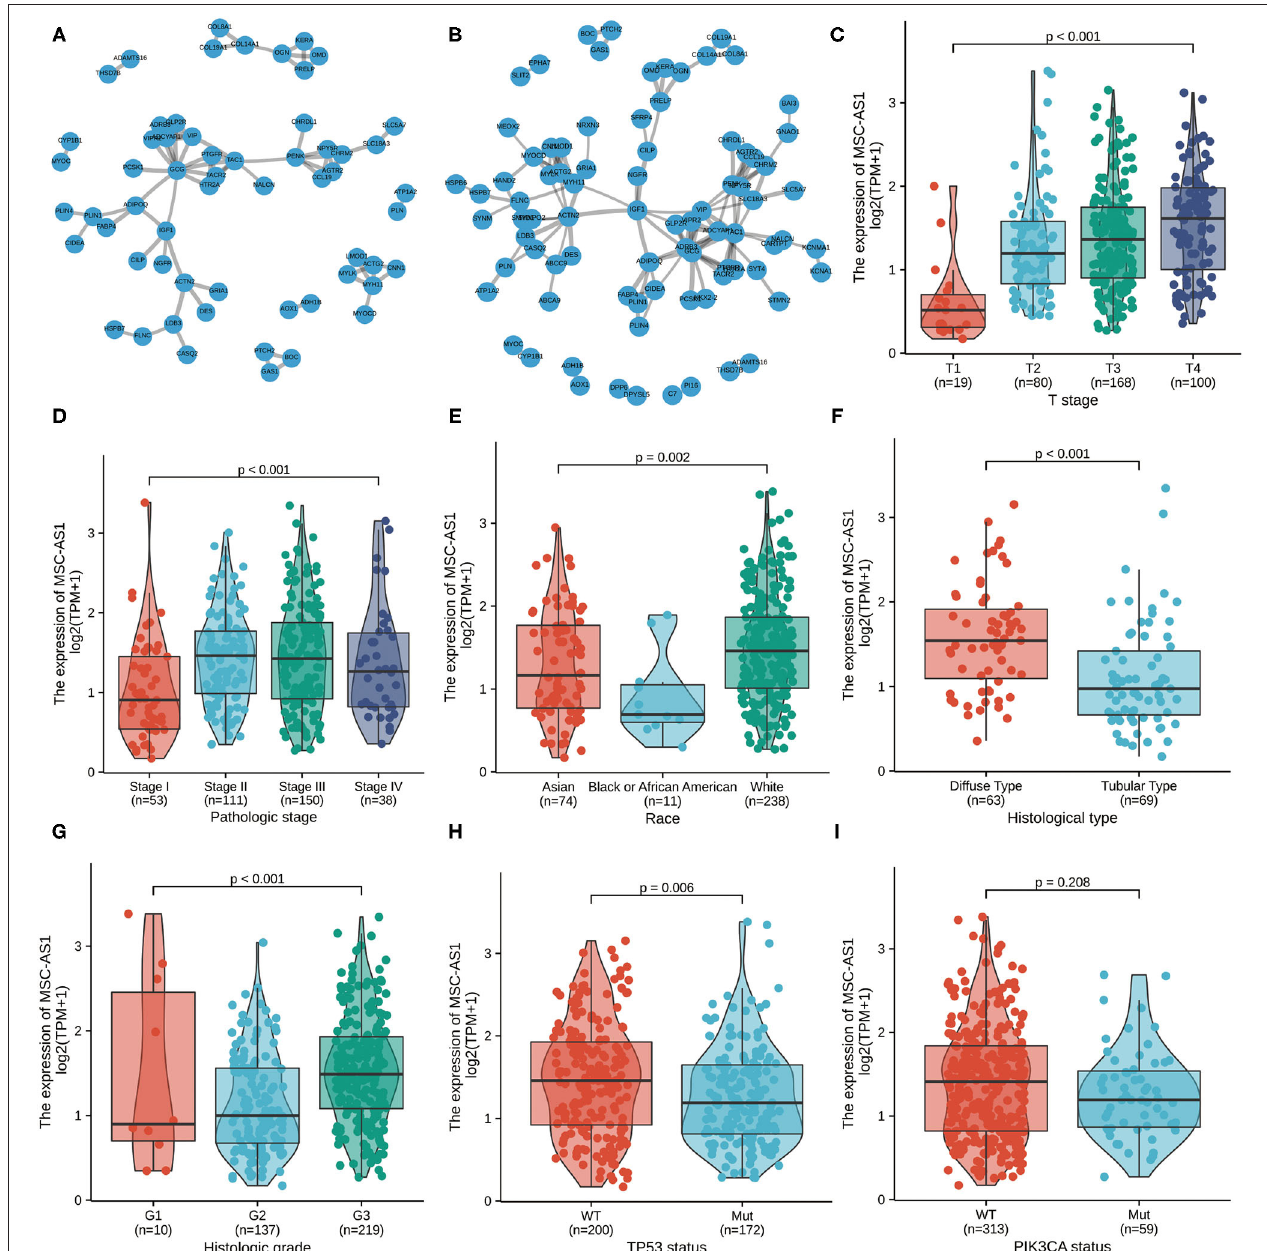
FIGURE 4 | The protein-protein interaction (PPI) network of MSC-AS1 was constructed. A network of MSC-AS1 and its co-expression genes was set up visually. The interaction threshold was set to 0.7 (A) and 0.5 (B) . Association of long non-coding RNA (lncRNA) MSC-AS1 expression and clinicopathological characteristics: (C) T stage; (D) pathological stage; (E) race; (F) histological type; (G) histological grade; (H) TP53 status; and (I) PIK3CA status.